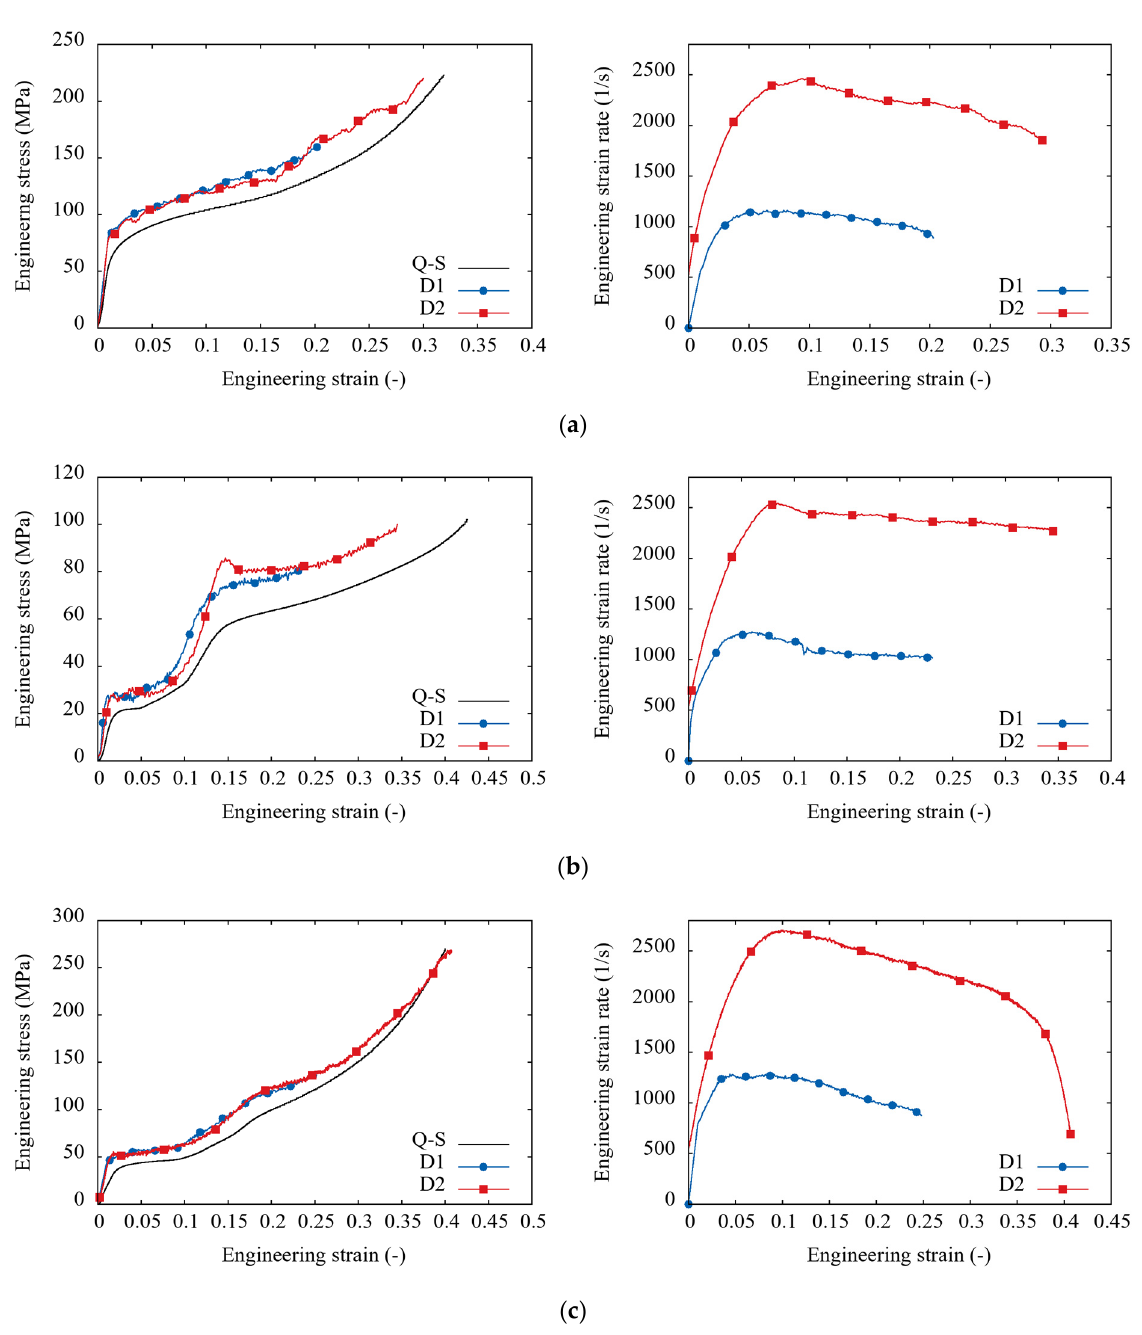
Figure 6. The average engineering stress-strain and strain-rate-strain relationships at lower (D1) and higher (D2) impact velocity: ( a ) hexa-chiral 2D, ( b ) tetra-chiral 2D, and ( c ) tetra-chiral 3D structure.